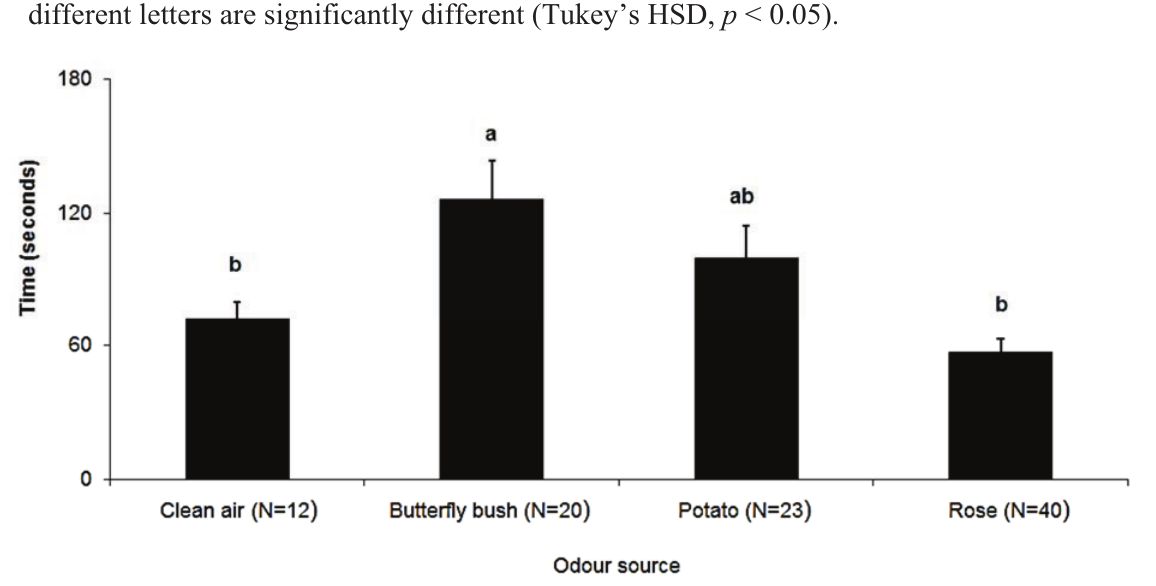
Figure 3. Proportion (X ± SEM) of M. euphorbiae males (N = 48 in each treatment) that oriented towards (dotted bars) or reached (striped bars) the different odour sources in wind tunnel assays. Columns with different letters, either for orienting to or reaching the source, are significantly different (Tukey’s HSD, p <